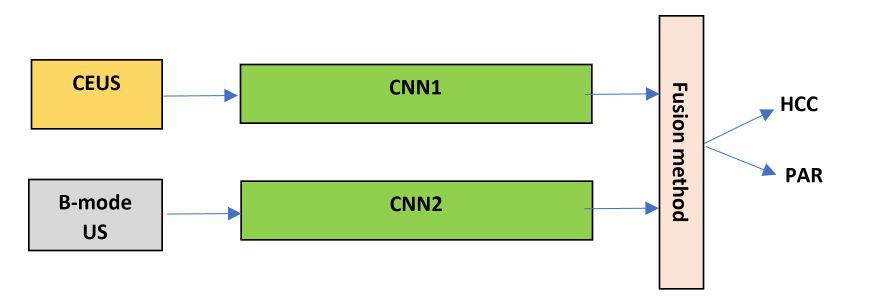
Figure 5. Decision level